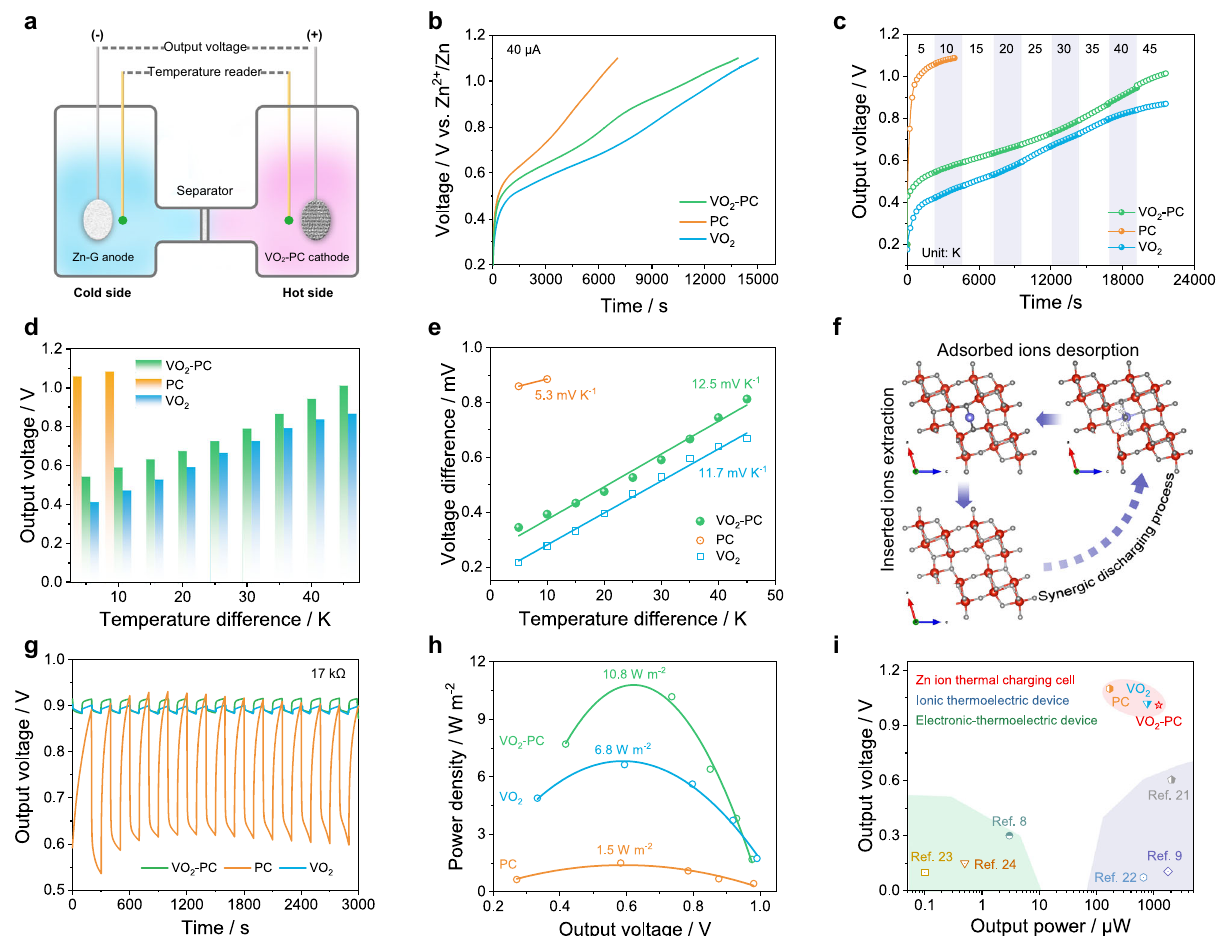
Fig. 2 Construction and performance of ZTCCs. a The schematic diagram of the non-isothermal cell. b Electrochemical charge curves with a current of 40 μ A. c Evolution of the output voltage with various temperature gradients. d The output voltage at various temperature differences. e Voltage difference vs. temperature difference. f The corresponding structural changes of VO 2 during energy conversion. g The discharging curves with a load of 17 k Ω . h Plots of current densities and power densities under various output voltages. i Comparison in output power and